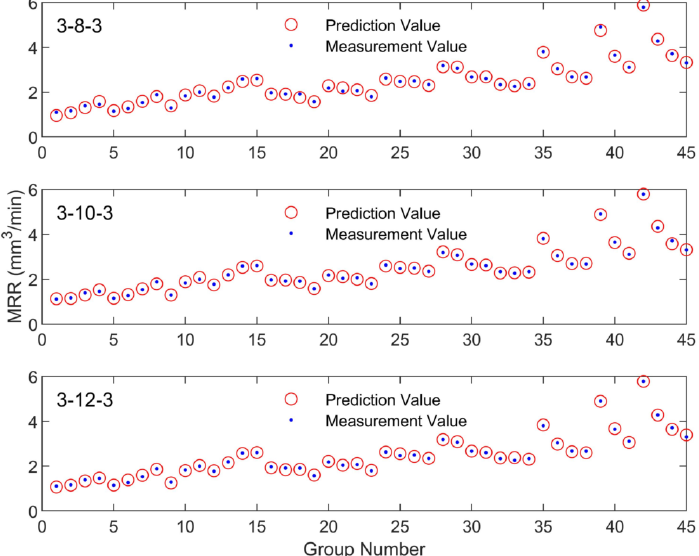
Figure 13. Comparison between the measurement and prediction values of the MRR obtained by three types of network